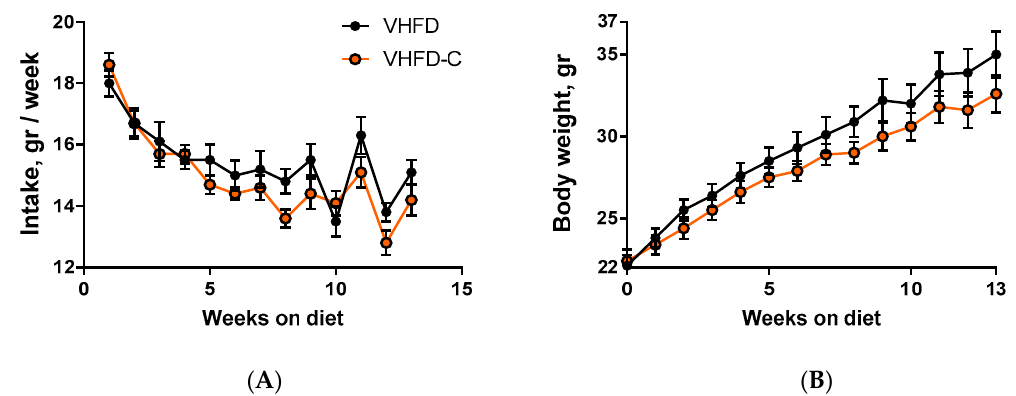
Figure 1. Effect of curcumin on food intake and mouse body weight. Mouse food intake and weight was measured weekly. ( A ) Food intake time course. ( B ) Body weight time course. p value for body weight area under the curve is 0.038. n = 10.